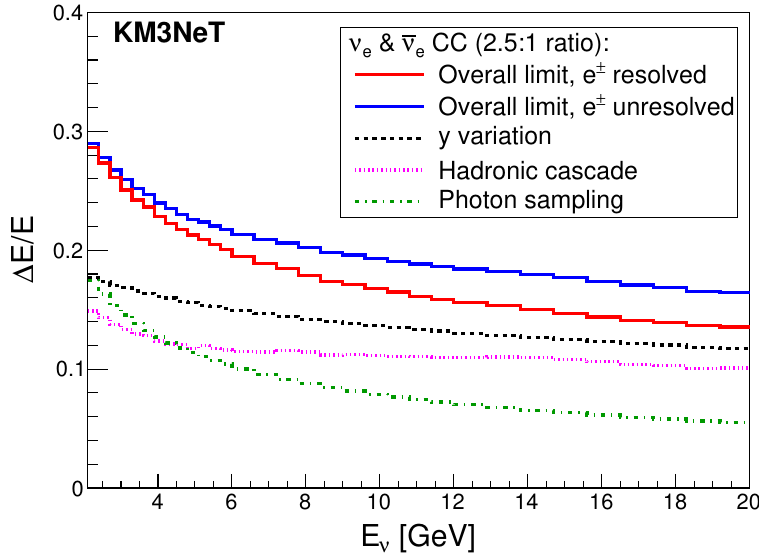
Figure 16 . Relative neutrino energy resolution (RMS) for (cid:23) e and (cid:23) e CC events (ratio 2.5:1) in the overall limit, assuming that photons from the outgoing e (cid:6) and hadronic cascade can (red solid) and cannot (blue solid) be resolved. For the unresolved case, contributions from variation due to unknown inelasticity y (black dashed), hadronic cascade (purple dotted) and photon sampling (green dashed-dotted) are shown separately.